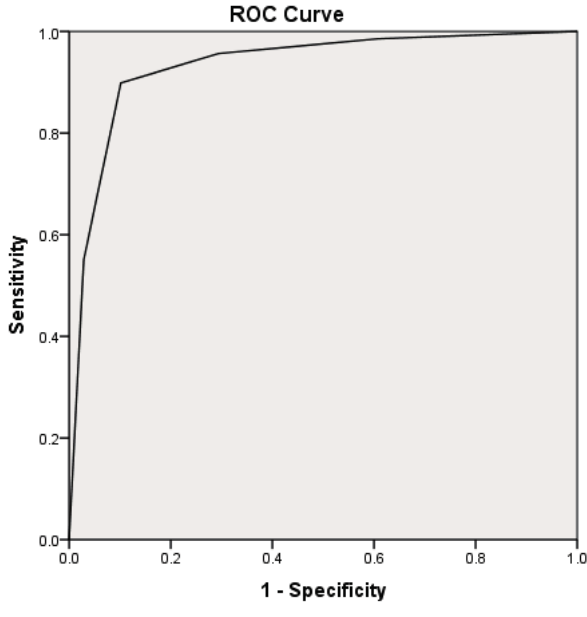
Figure 2. ROC analysis for DEM risk scale in discriminating DEM cases from non-DEM